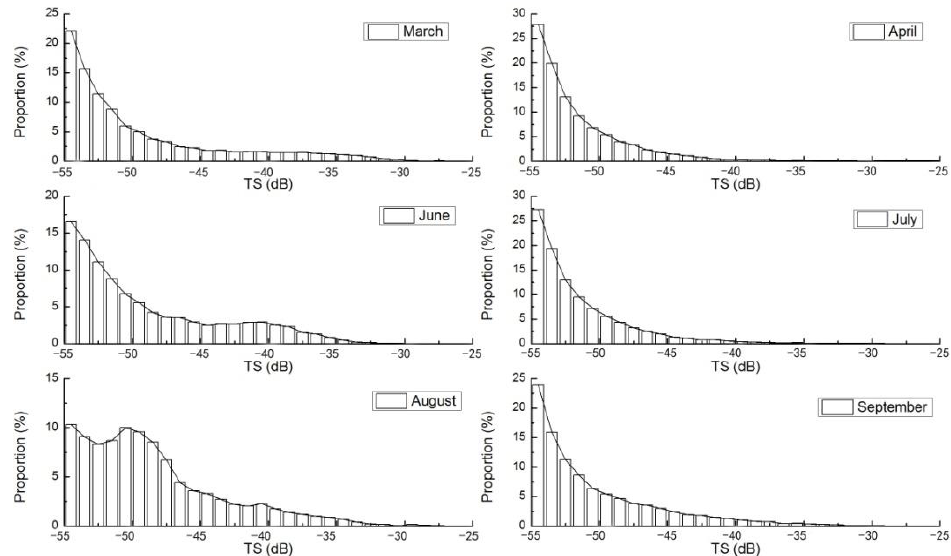
Figure 5. Target strength (TS) distributions in different months in 2016. To reveal differences in the fish assemblages, fish lengths were converted from TS (Equation (1)) to delineate the proportions of the two groups (i.e., large and small fish). Figure 6 shows the range of the fish length distribution and the probability density. Fish